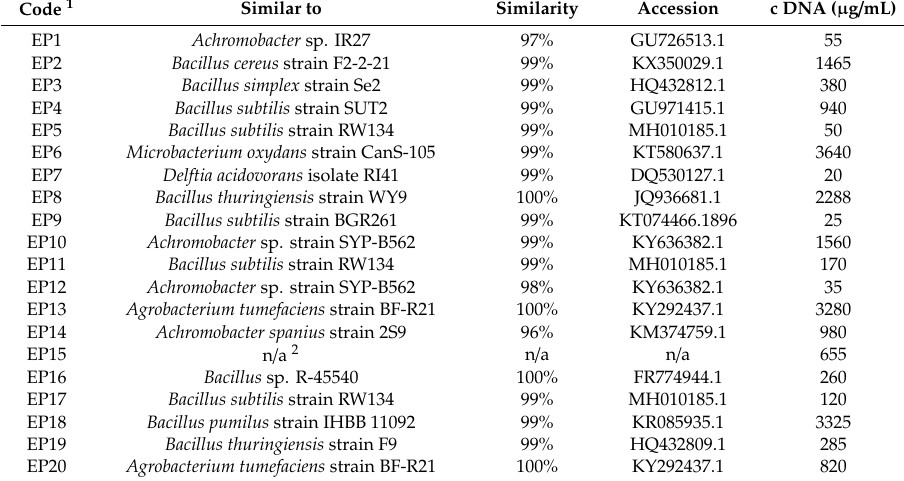
Table A1. Similarity of the obtained isolates to the sequences deposited in GenBank (NCBI) and the concentration of obtained